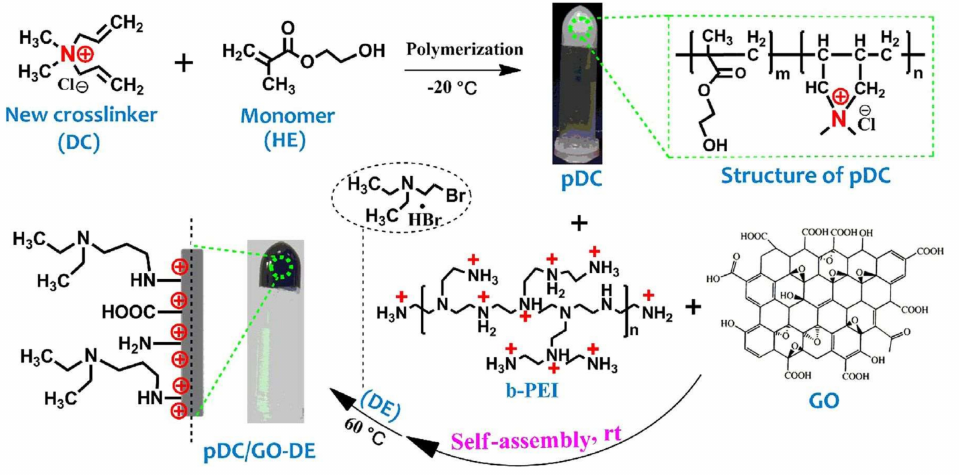
Figure 9. Scheme of composite cryogels preparation. Republished with permission from [61]. Copyright 2019